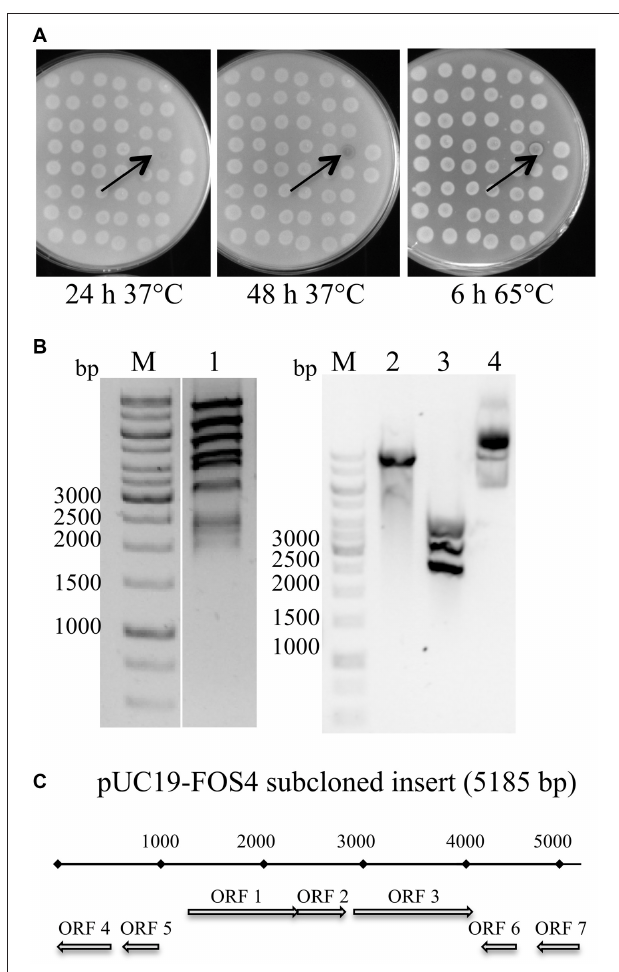
FIGURE 4 | Selection, subcloning, and identification of the LOB4Est gene: (A) Images of the screening plate containing the lipolytic positive clone FOS4 after incubation for 24 and 48h at 37 ◦ C, and 6h at 65 ◦ C. (B) Analysis by electrophoresis in agarose gels (0.8%) of: 1- digestion by SphI and EcoRI of fosmid FOS4 (2686bp); 2- digestion by EcoRI of subclone in plasmid pUC19 (2628bp); 3- digestion by SphI of subclone in plasmid pUC19; 4- subclone in plasmid pUC19 undigested. M: GeneRuler 1kb DNA Ladder (Fermentas). GelGreen stain. (C) Physical map of the insert of FOS4A subcloned into pUC19. Best BLASTP hits are shown in Table 2 . The arrows into (A) point to the FOS4 clone. The arrows into (C) indicate the positions of the